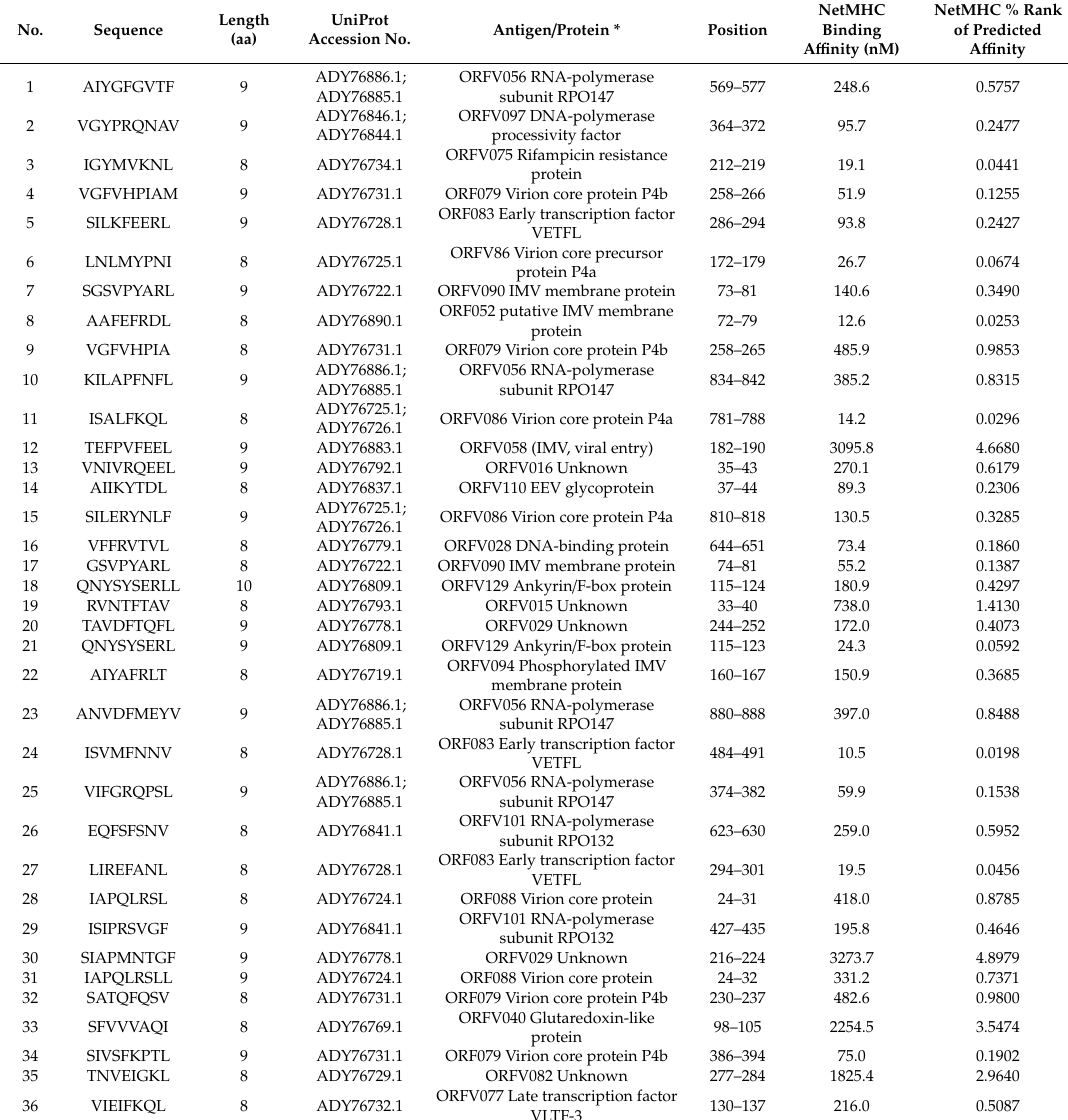
Table 1. H-2K b -associated peptides derived from the D1701-V Orf virus